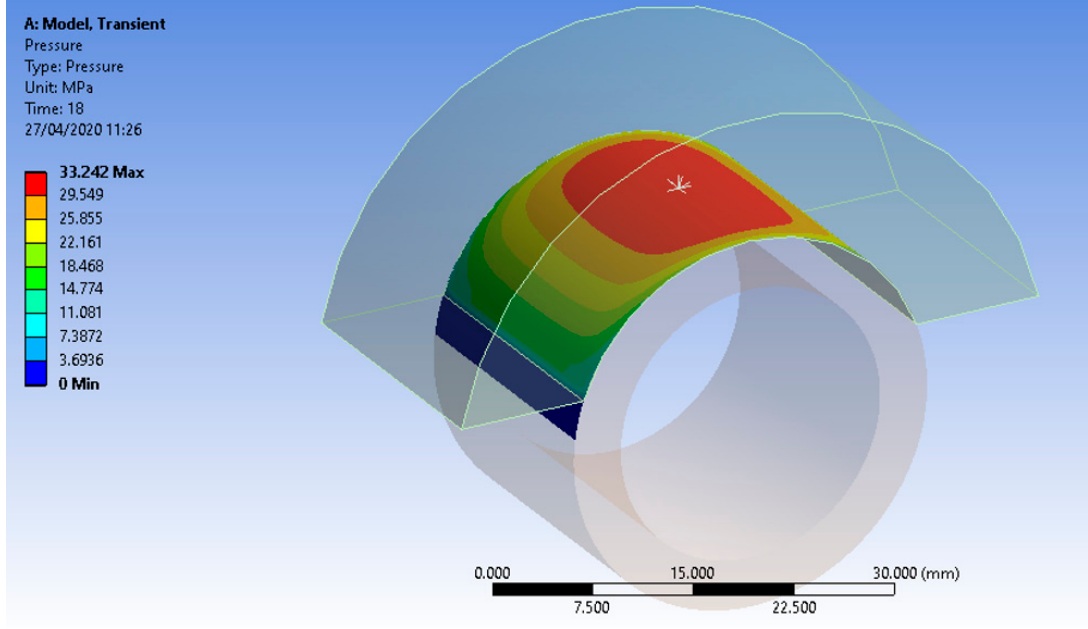
Figure 6. The pressure exerted by the sabot on the test piece surface.